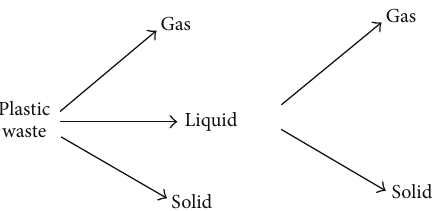
Figure 5: The second set of reactions that convert the liquid product to solid and gas.